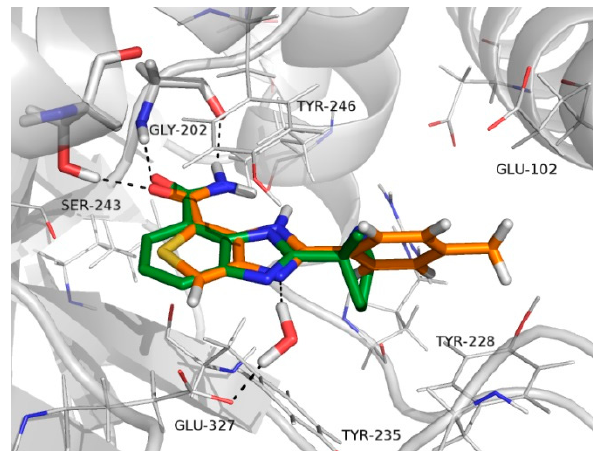
Figure 3. Proposed binding mode of compound 16l overlaid with the X-ray co-crystal structure of Veliparib. Key amino acids are depicted as sticks and the atoms are coloured as carbon-grey, hydrogen-grey, nitrogen-purple and oxygen-red. Ligands are distinguished by differently coloured carbon atoms; Veliparib coloured as carbon-green and compound 16l coloured as carbon-orange.